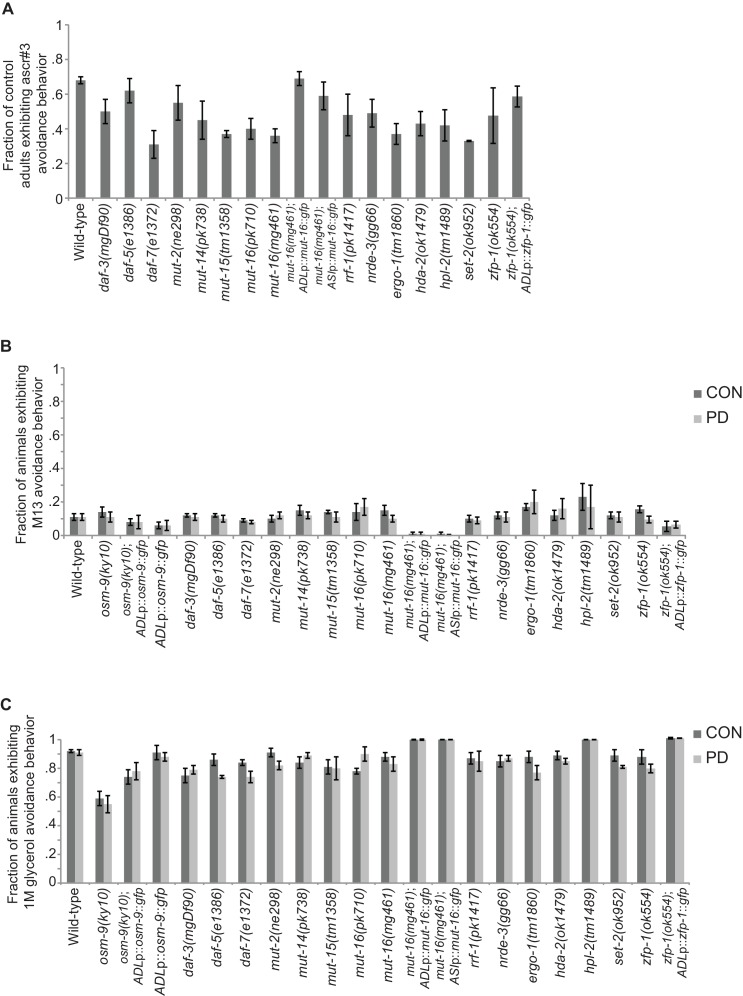
Strains tested for ascr#3 avoidance exhibited expected behaviors for positive and negative controls.(A) Fraction of CON adults from strains in Figures 3C, 4B, and 5B that exhibit ascr#3 avoidance behavior. (B) Fraction of CON and PD adults from strains in Figures 1D, 3C, 4B, and 5B that exhibit M13 avoidance behavior (negative control). (C) Fraction of CON and PD adults from strains in Figures 1D, 3C, 4B, and 5B that exhibit 1 M glycerol avoidance behavior (positive control). Data for neuron-specific rescue strains is average values for two independent extrachromosomal lines. Error bars represent S.E.M. (Figure 3—figure supplement 2—source data 1).DOI:
http://dx.doi.org/10.7554/eLife.11642.02210.7554/eLife.11642.023Figure 3—figure supplement 2—source data 1.Spreadsheet containing avoidance responses CON and PD adults to M13 and 1 M glycerol.Normalized avoidance responses of CON adults to ascr#3 are also included.